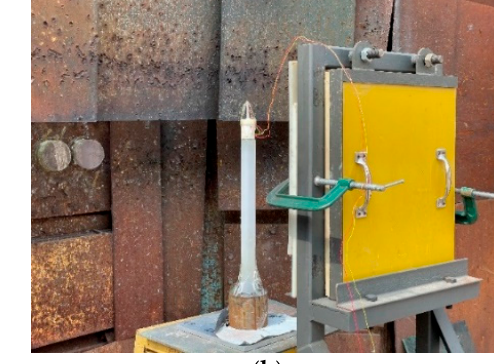
Figure 3. Experimental principle and setup of X ‐ ray: ( a ) principle; ( b ) setup.